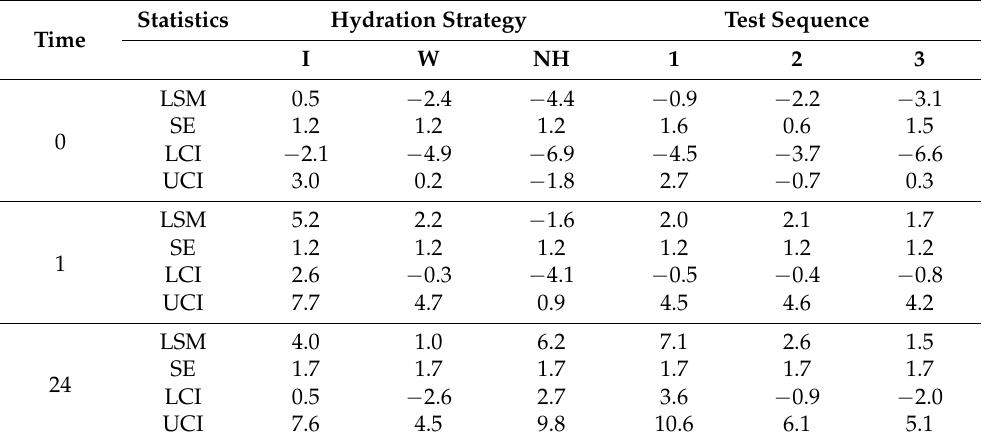
Table 5. Results for plasma volume change ∆ PV [%] estimated using Dill and Costill’s formula (1974) as modified by Harisson et al. (1982). Calculations were made based on HB and HCT results measured before the test and 0, 1, and 24 h after the test, performed with different hydration strategies in three consecutive tests: marginal means (LSM), standard errors (SE), and upper (UCI) and lower (LCI) confidence intervals.